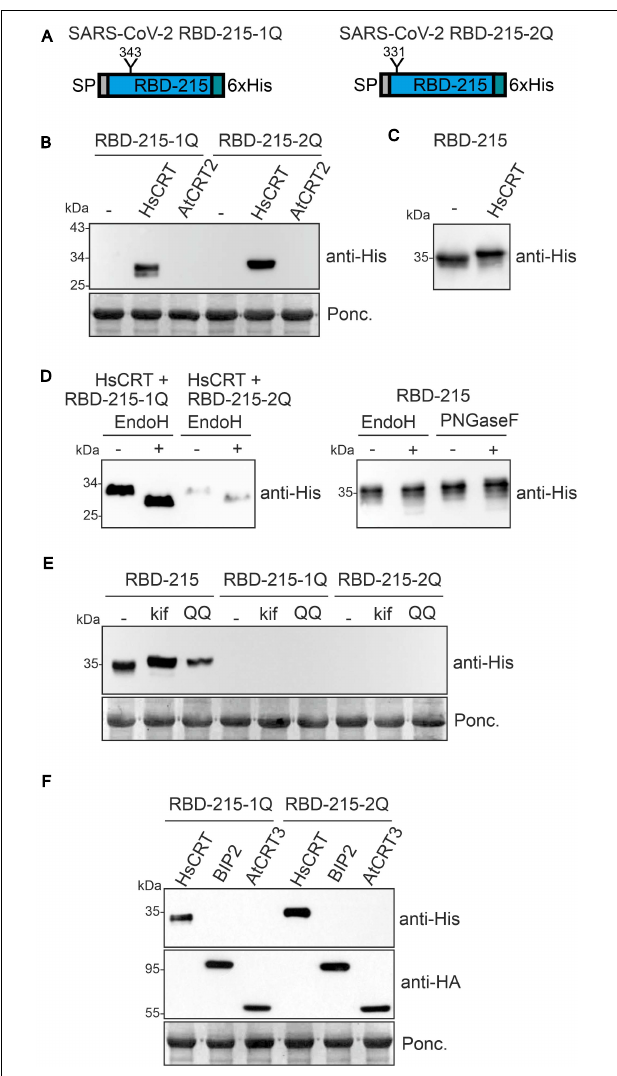
FIGURE 5 | N-glycosylation at both sites of the truncated RBD variant is required for expression in Nicotiana benthamiana . (A) Schematic illustration of the mutated RBD-215 variants lacking the indicated N-glycosylation sites. (B) RBD-215-1Q and RBD-215-2Q were co-expressed with HsCRT or AtCRT2 and samples were analyzed 4 days after infiltration of N. benthamiana WT by immunoblotting. (C) RBD-215 co-expressed with HsCRT is shown as a control. (D) Protein extracts from infiltrated N. benthamiana WT were subjected to Endo H or PNGase F digestion and analyzed by immunoblotting with anti-His antibodies. (E) RBD-215-1Q and RBD-215-2Q were co-expressed with kif or Arabidopsis CDC48A-QQ (QQ). Samples were analyzed 3 days after infiltration of N. benthamiana WT. (F) RBD-215-1Q and RBD-215-2Q were co-expressed with Arabidopsis BIP2 or Arabidopsis CRT3 both carrying an HA-tag for